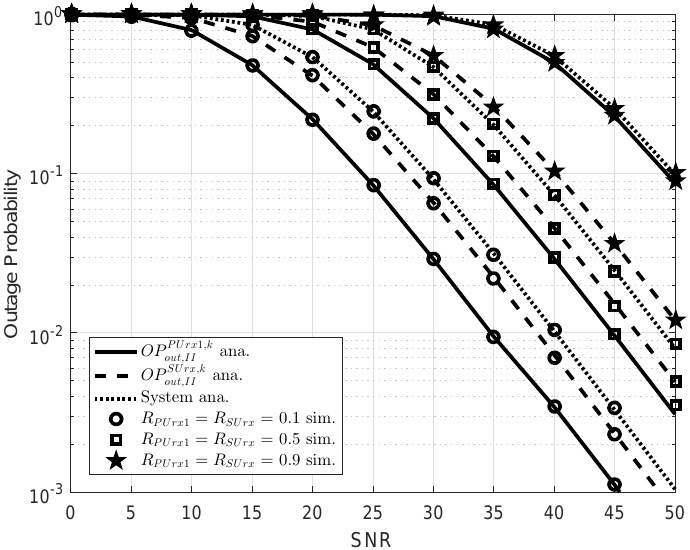
Figure 5. Scheme 1: Outage performance of PUrx 1 and SUrx under changing of a 2 R SUrx = 0.1).